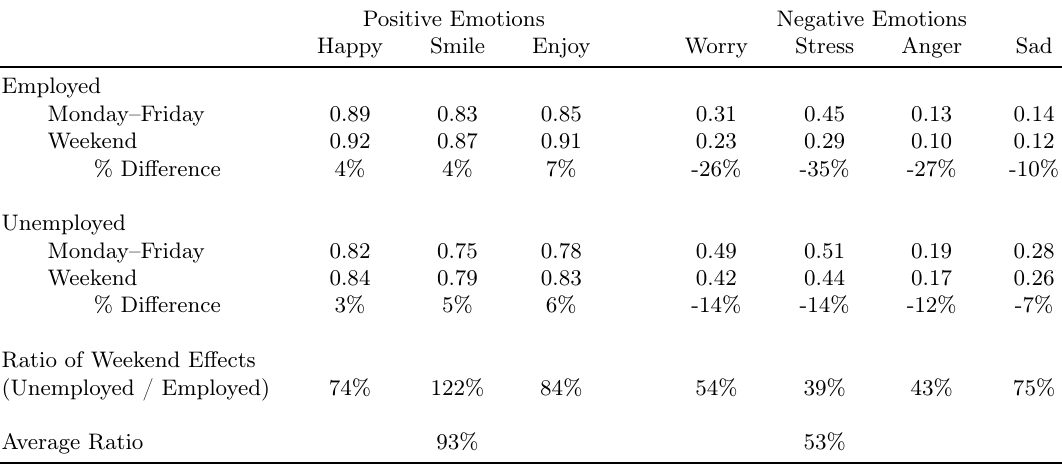
Table 1: Average Number of Emotions Experienced, by Variable Positive Emotions Negative Emotions Happy Smile